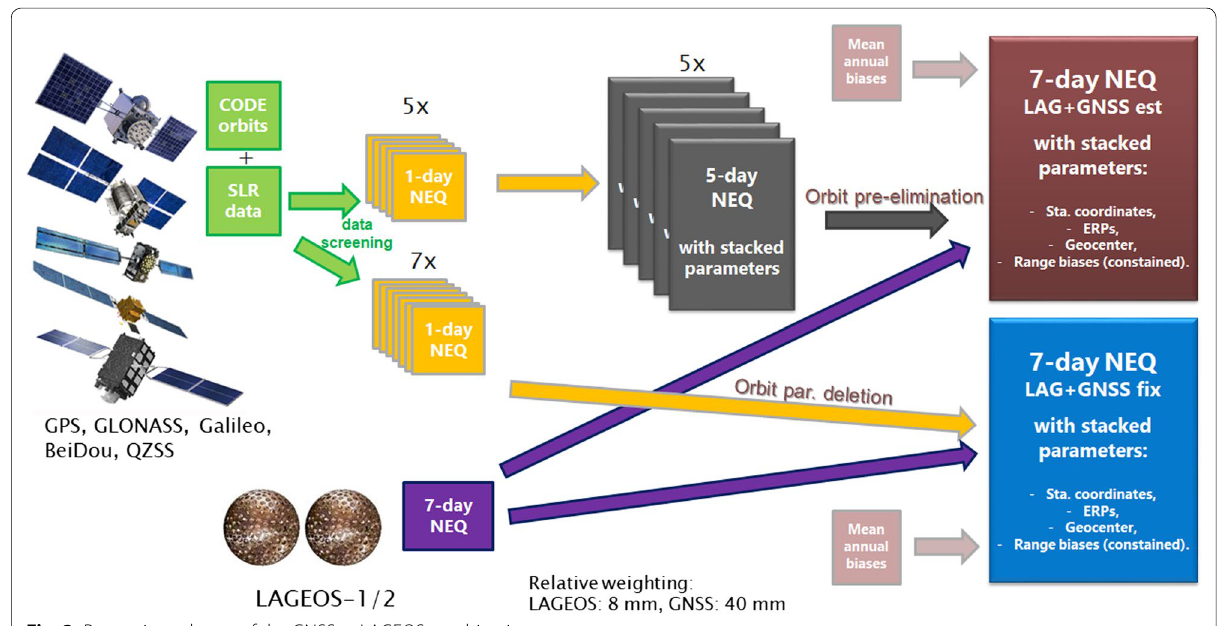
Fig. 3 Processing scheme of the GNSS